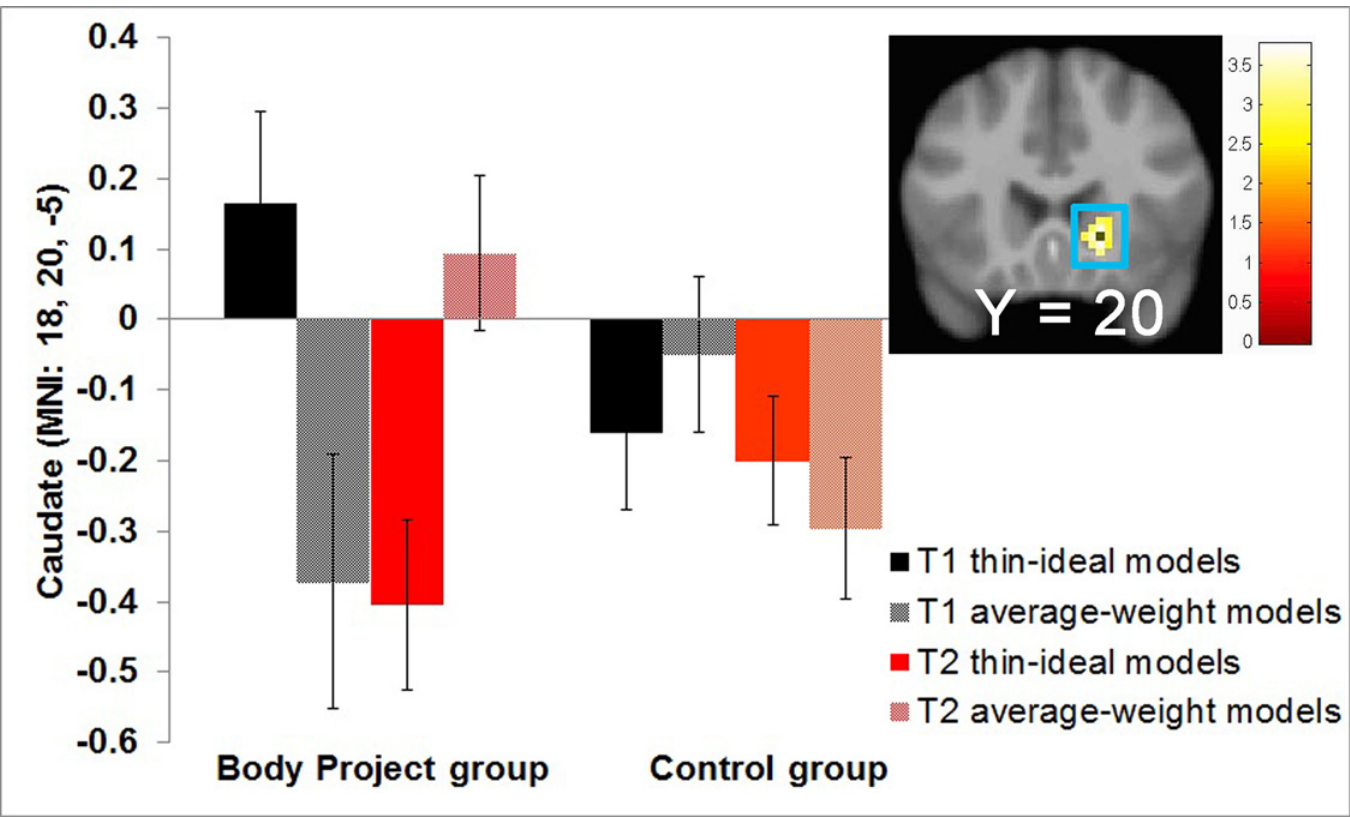
Fig 3. Greater pre to post BOLD response decreases in the right caudate (MNI: 18, 20, 5, Z = 3.66, k = 37; r = -0.59) in response to thin-models relative to average-weight models.